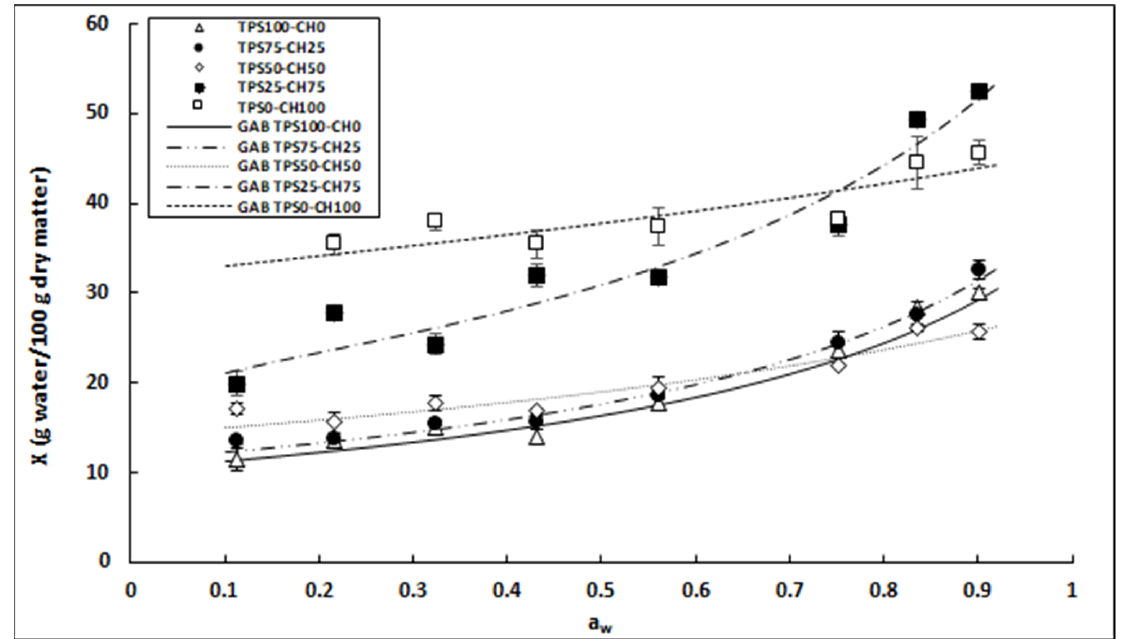
Figure 5. Moisture adsorption isotherms of starch:chitosan films at 25 °C, experimental data (symbols), and fitted to the GAB model (lines).